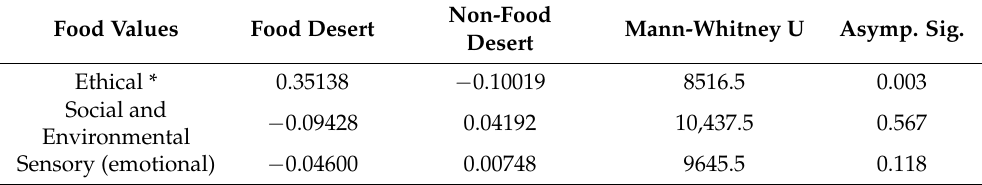
Table 9. Perception of underlying dimensions by food desert and non-food desert. Food Values Food Desert